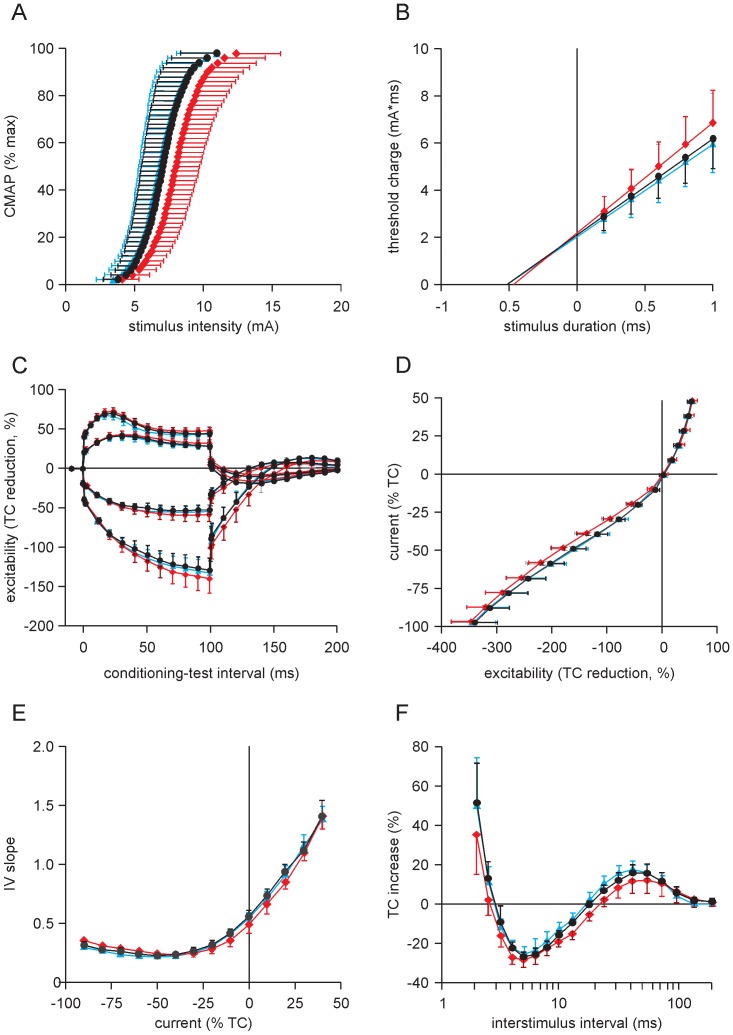
Changes in components of axonal excitability after sustained activity.Black symbols: control data; red symbols: data recorded after the 1 min sustained contraction; blue symbols: data recorded after the 40 min recovery period. A: stimulus-response curves with the CMAP normalised to Mmax. B: charge-duration curves. τ
SD and rheobase were derived from the x-intercepts and gradients of the linear regressions, respectively. C: threshold electrotonus. D: current-threshold relationship. E: slope of the current-threshold relationship. F: recovery cycle. Four subjects were excluded from the data at an interstimulus interval of 2 ms only because the output of the stimulator was insufficient to produce the target potential. Data presented as mean ± 95% confidence intervals. TC: threshold current.